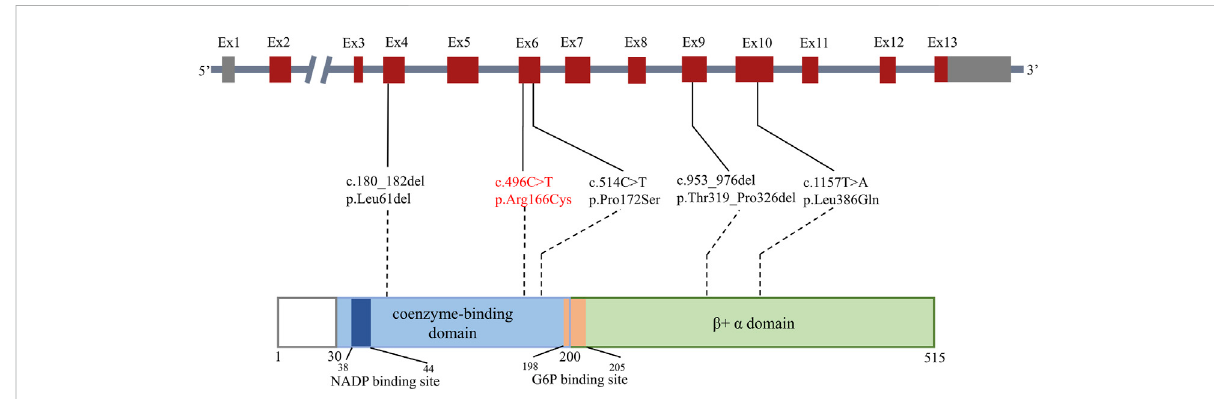
FIGURE 5 Mutations related to severe G6PD de fi ciency and potential neutrophil dysfunction. The bar above shows the distribution of reported gene mutations in thecDNA. The bar below shows thedistributionof reported gene mutations in theprotein. Exons are shown as thick numbered blocks, andintronsareshownasthinlines.Noncodingregionsareingray.Themutationc.496 C > Tinourstudyisinred.Thelongintrontwoisindicatedbya diagonal double